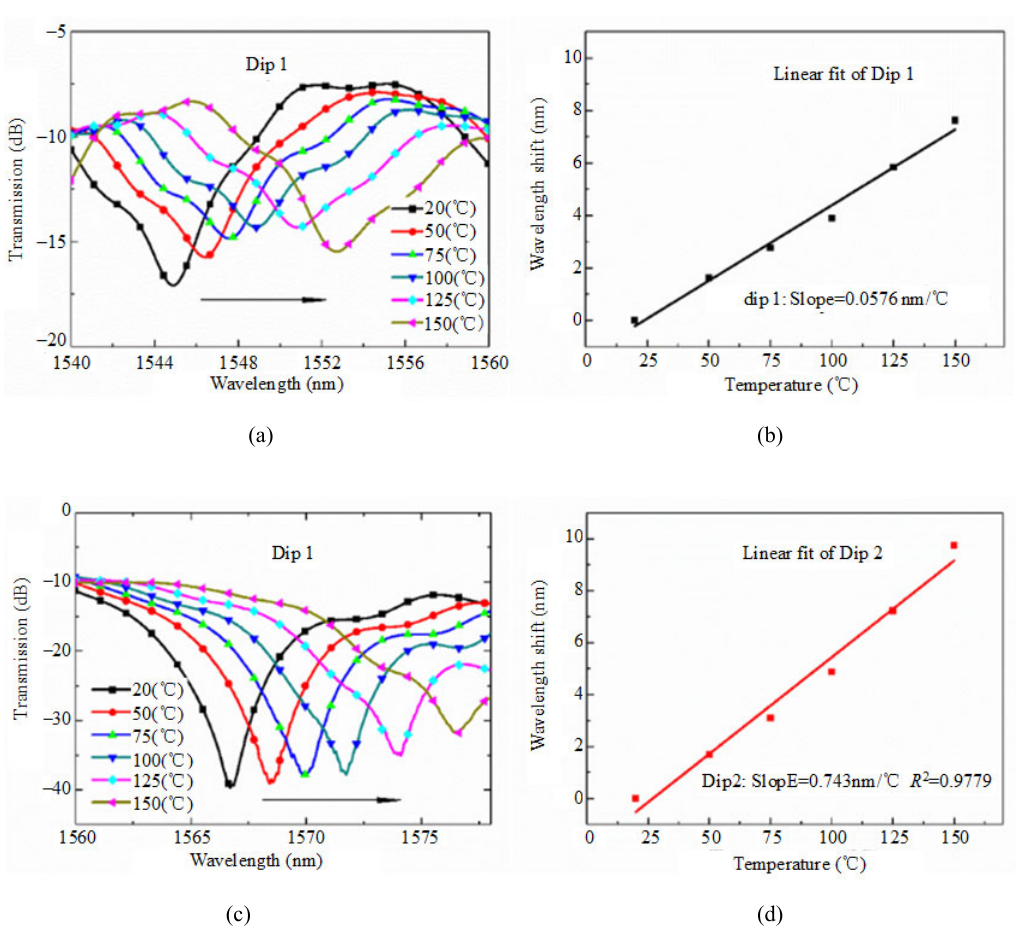
Fig. 9 Results of temperature response experiment: (a) and (c) transmission spectrum change of the MZI as the temperature increases; (b) and (d) the linear relationship between the temperature and the wavelength